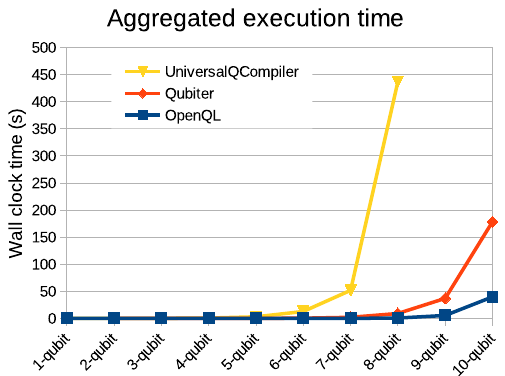
Figure 16. Execution time of the decomposition and circuit generation for OpenQL, Qubiter and UQC for different sizes of unitary